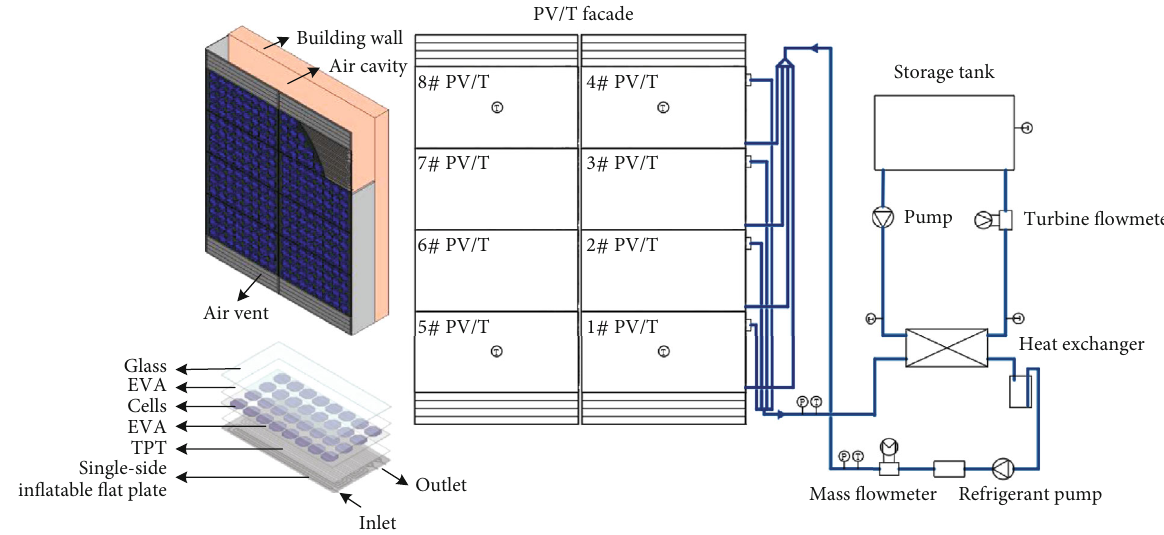
Figure 2: The infrared thermal imaging of the PV/T façade system.